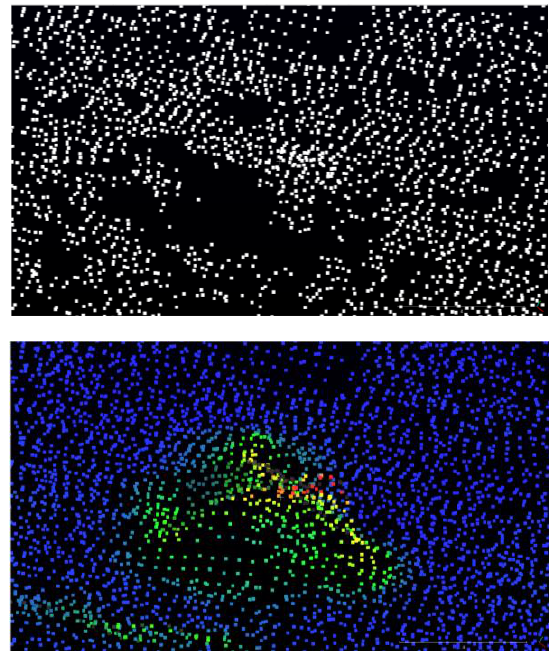
Figure 1. Terrain data derived by utilizing Terrasolid (top) and newly reconstructed terrain data with protruding rock extracted by the proposed algorithm